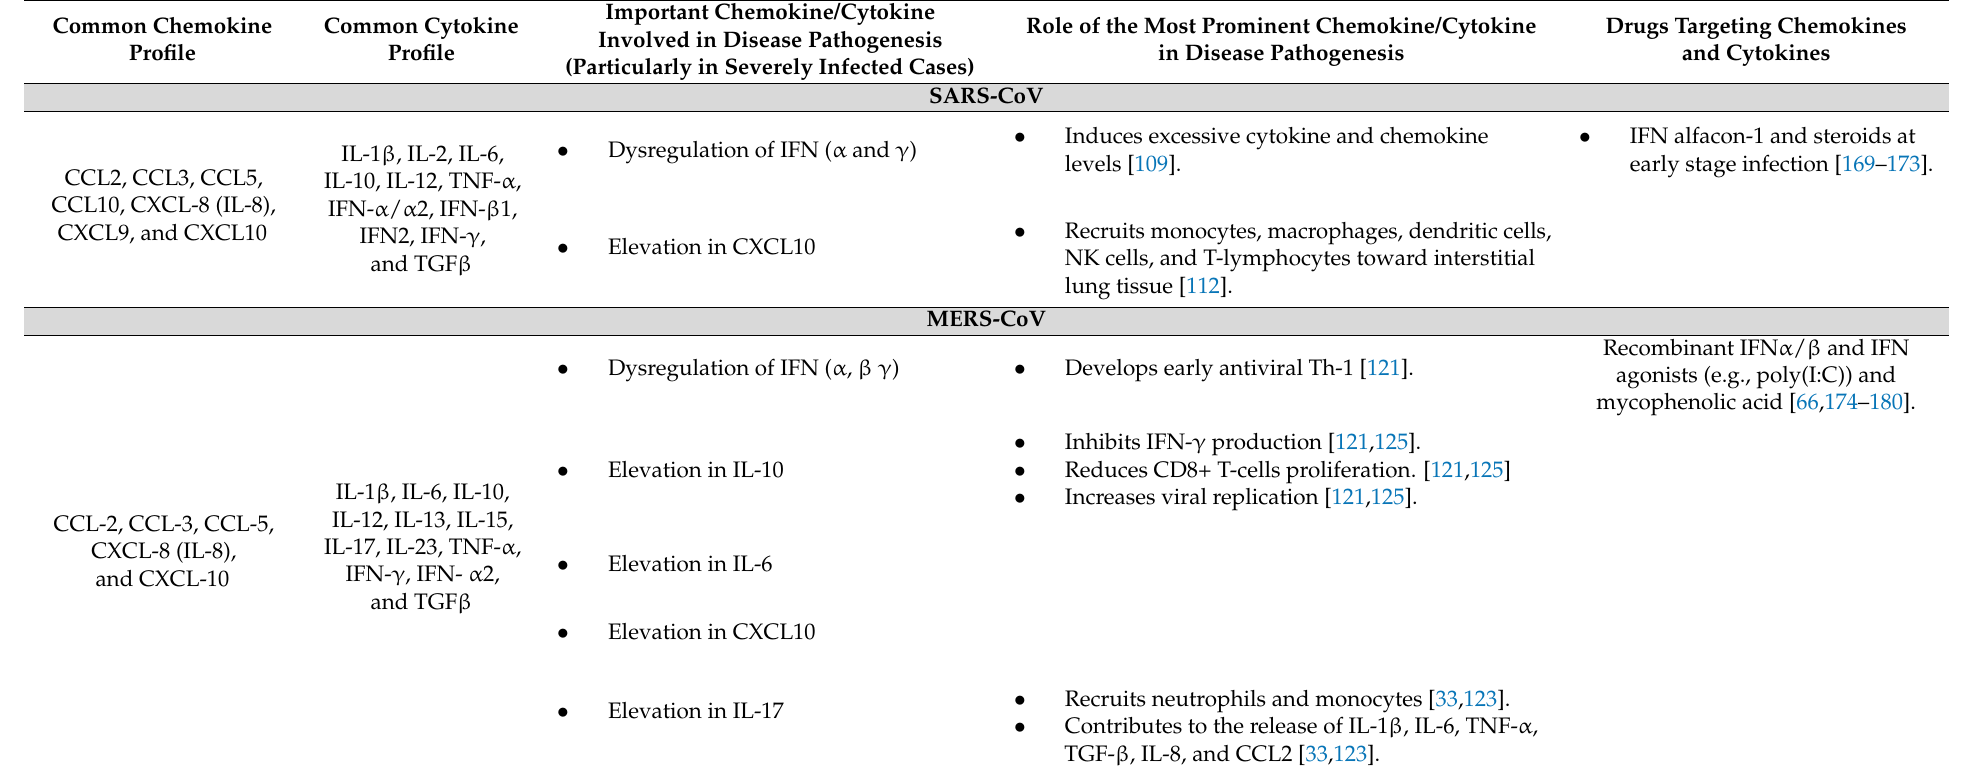
Table 1. Summary of the common cytokine and chemokine profile of patients infected with SARS-CoV, MERS-CoV, and